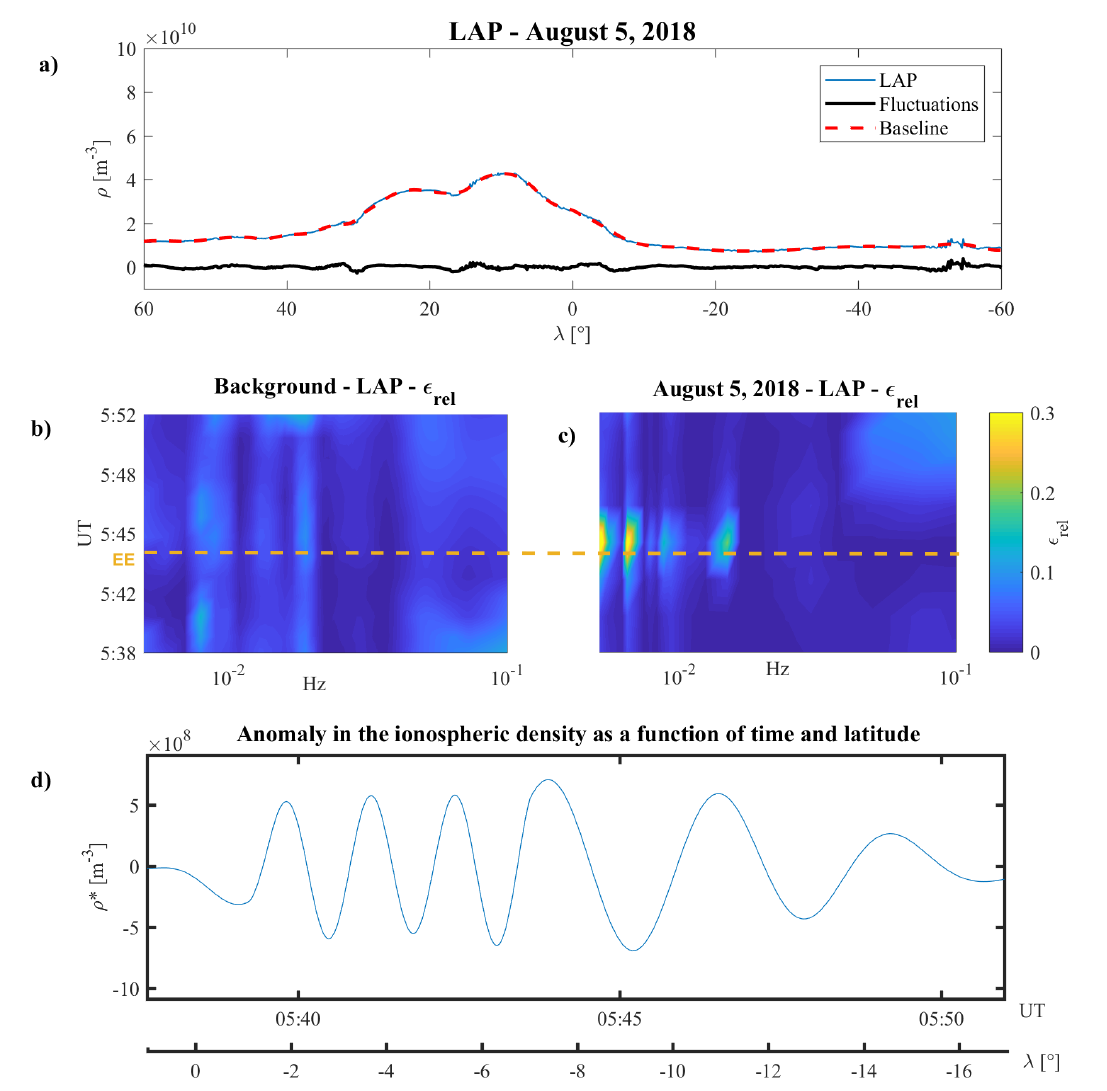
Figure 9. CSES satellite LAP observations. Panel ( a ) Ionospheric plasma density: blue line is the observations for the entire 5 August 2018 orbit; red dashed line is baseline; black line represents the plasma density fluctuations; Panel ( b ) environmental background evaluated over the earthquake epicenter in terms of ¯ (cid:101) rel vs. time and frequency for the reference quiet condition ( M ≤ 2; Sym-H = [10 nT, − 10 nT]; AE < 100 nT); panel ( c ) (cid:101) rel evaluated over the earthquake epicenter on 5 August 2018; panel ( d ) plasma density anomaly ( ρ ∗ ) obtained by the superposition of the two frequency components, T 1 = 67 ± 1 s and T 2 = 111 ± 1 s. Orange horizontal dashed line represents the time at which the satellite flew over the EE position. Colors in panels ( b , c ) are representative of the (cid:101) rel